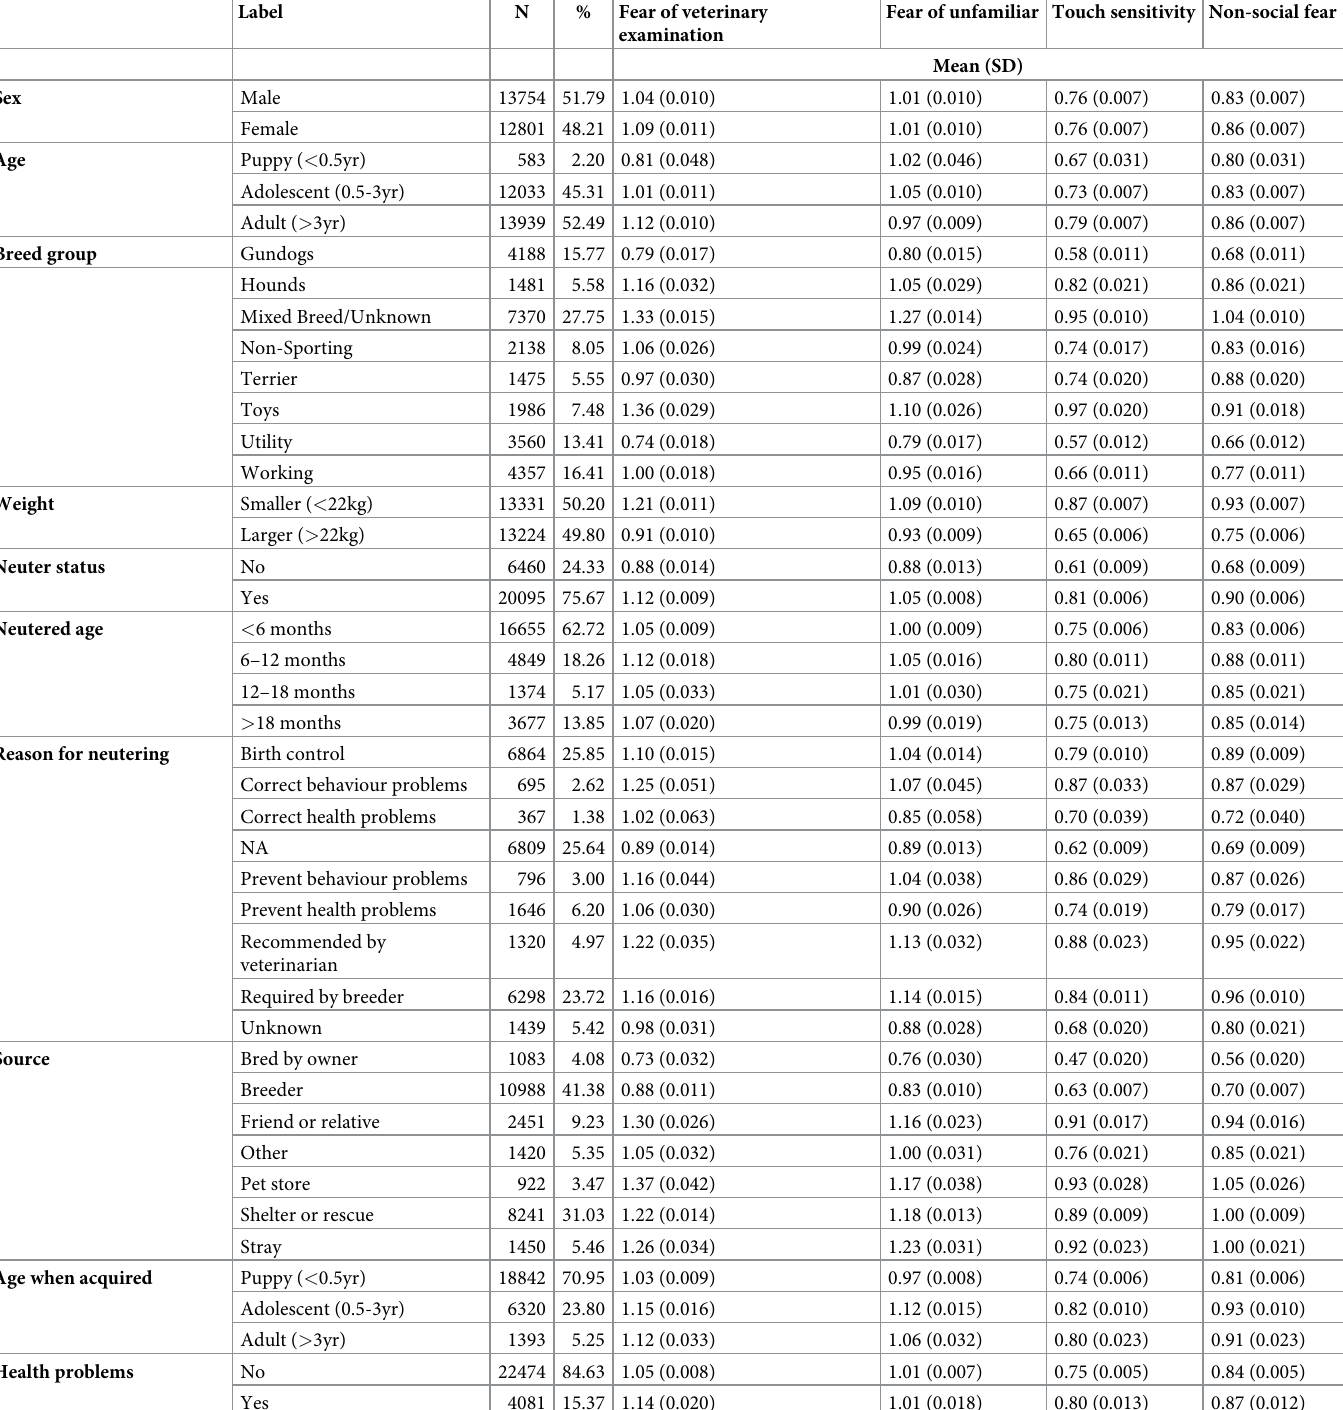
Table 1. Summary of demographic and environmental covariates and cross-tabulation with mean and standard deviations (SD) of C-BARQ fear variables (with ‘0’ being ‘no fear’, and ‘4’ being ‘extreme